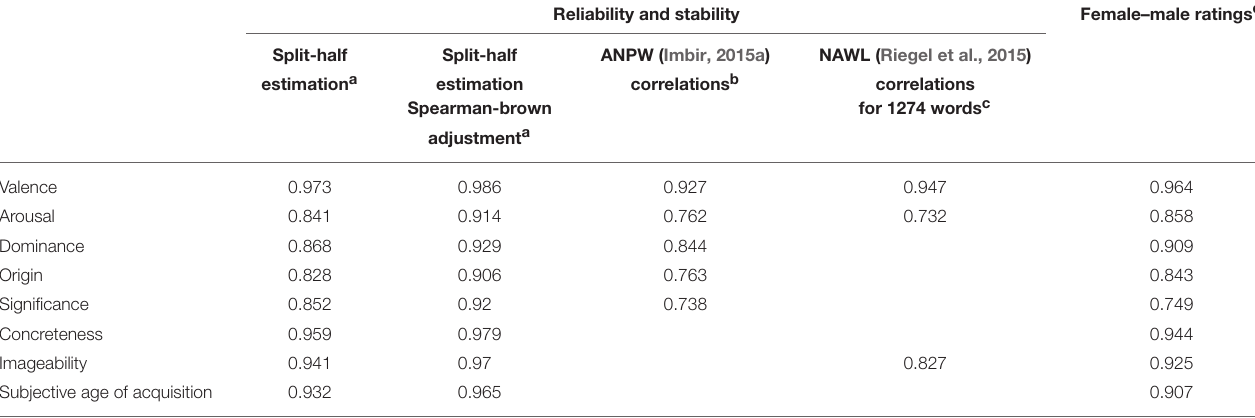
TABLE 3 | Reliability estimations for each variable.